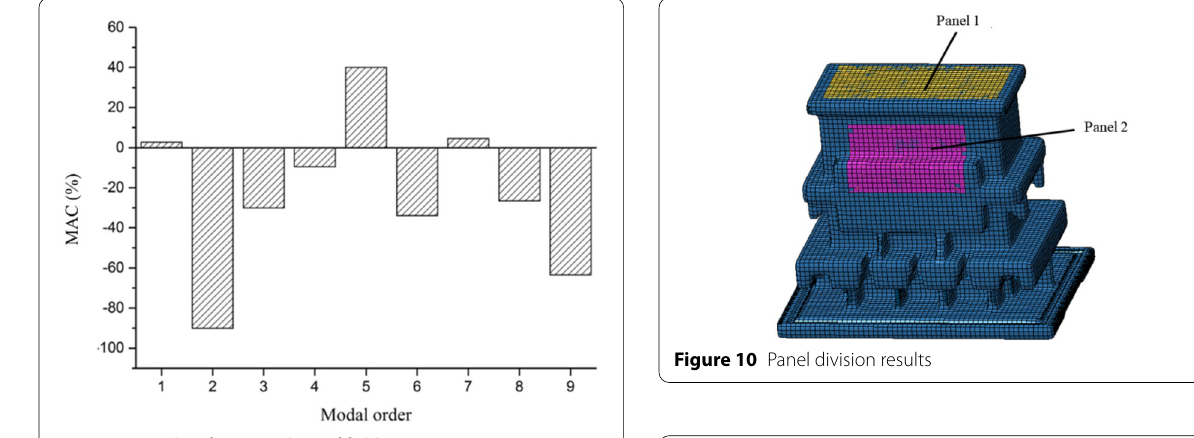
Figure 8 Results of MAC analysis of field point 1